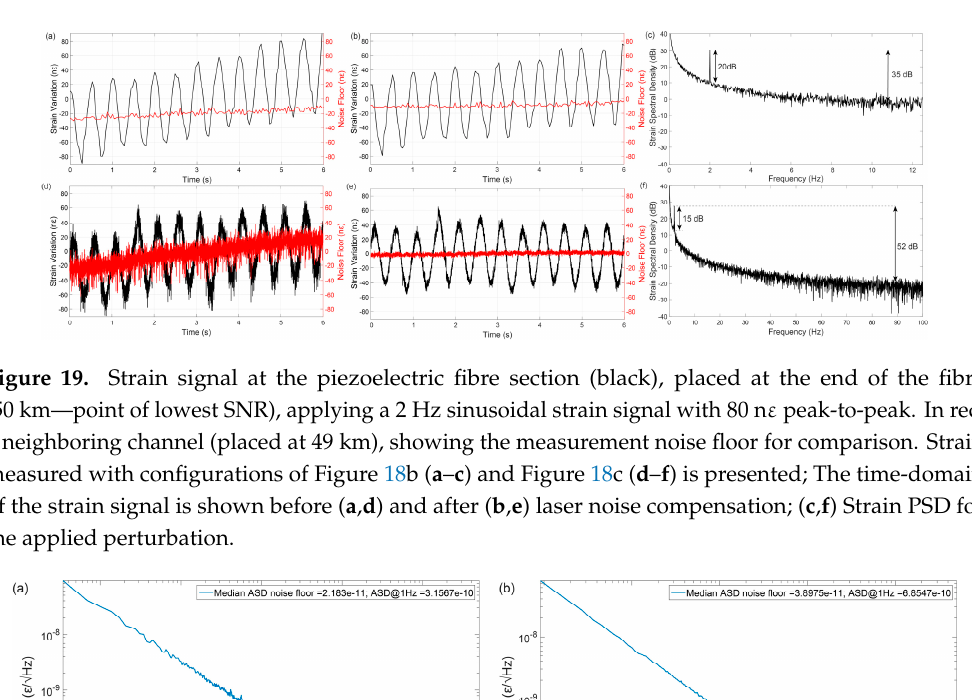
Figure 21. Fibre trace SNR (black), inverted strain ASD (red), and equivalent laser noise level electrical noise floor (blue), with 100 ns FWHM pulses ( τ ) and 1 kHz pulse repetition rate ( f ) along: ( a ) 75 km, pulse peak , s ac p power = 30 mW, without averaging, bi-directional Raman amplification (co-propagating Raman pump = 270 mW, counter-propagating Raman pump = 245 mW); ( b ) 100 km, pulse peak power = 30 mW, with 20 averages of the optical trace, bi-directional Raman amplification (co-propagating Raman pump = 300 mW, counter-propagating Raman pump = 380 mW). Insets show the photodetected traces. The sensor strain ASD is maintained above 150 p ε / √ Hz and 400 p ε / √ Hz, respectively noise floor (corresponding to a strain standard deviations of ≈ 3.3 n ε and ≈ 2 n ε , see Equations (13) and (17)) in even for long ranges.